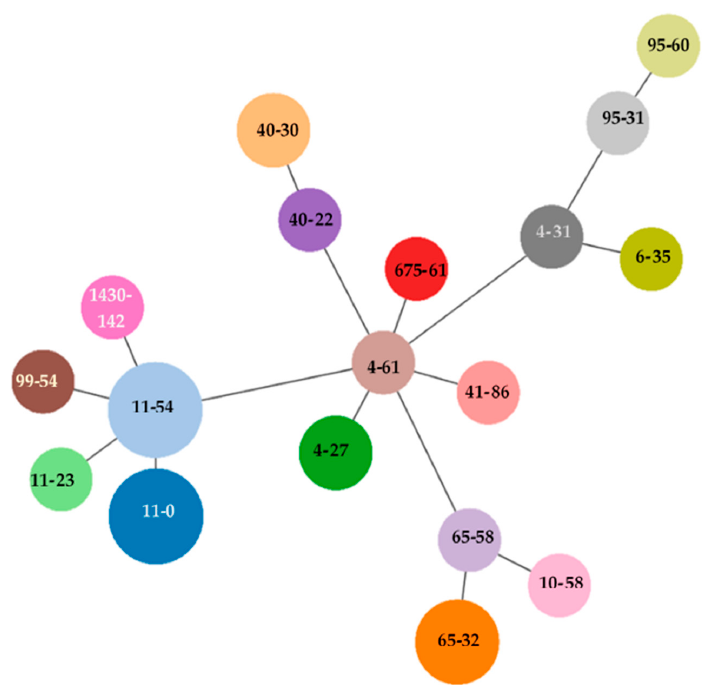
Figure 1. goeBURST diagram for the CH clonotyping data set (CHs in parenthesis) of 28 E. coli isolates. An eBURST diagram was calculated using PHYLOViZ with the goeBURST algorithm. E. coli isolates were grouped according to their CH profiles.